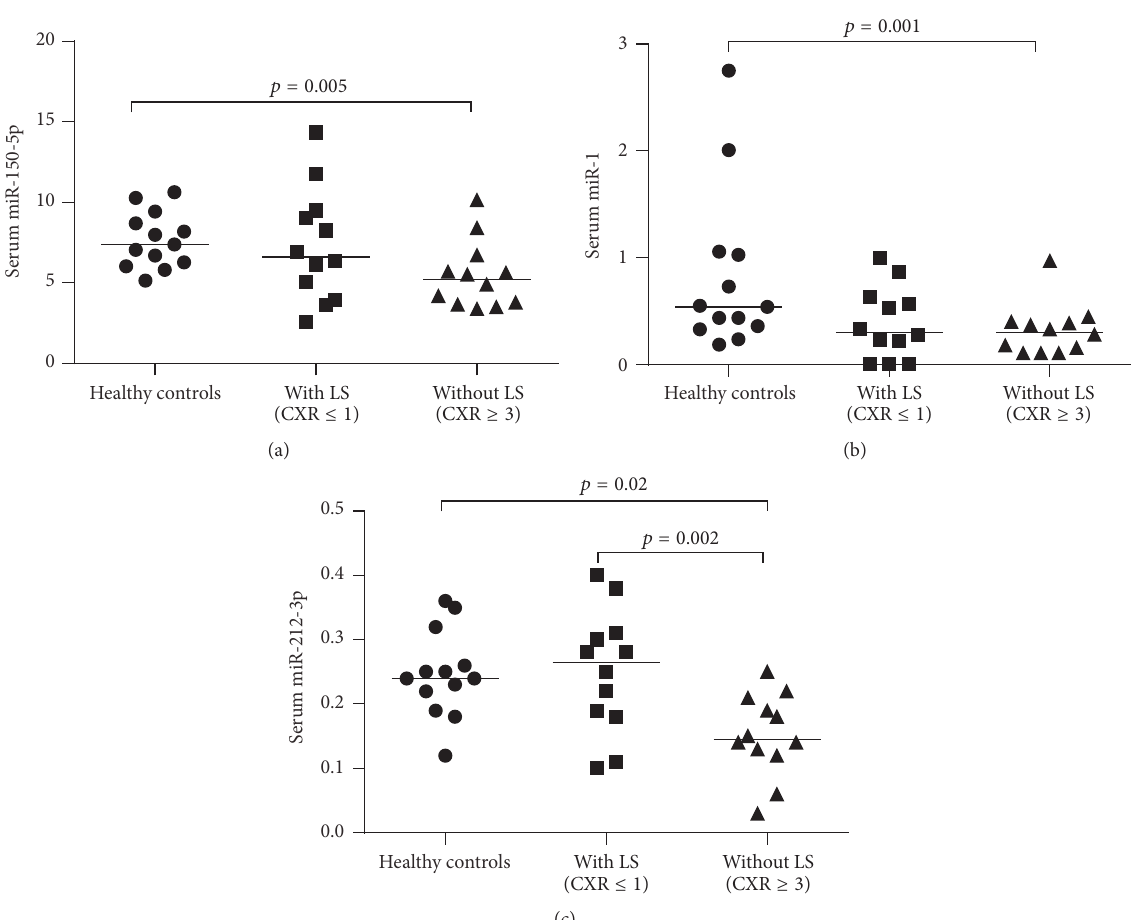
Figure 2: Serum miRNAs only dysregulated in sarcoidosis patients without L¨ofgren’s syndrome compared to healthy controls. CXR, chest X-ray and LS, L¨ofgren’s syndrome.